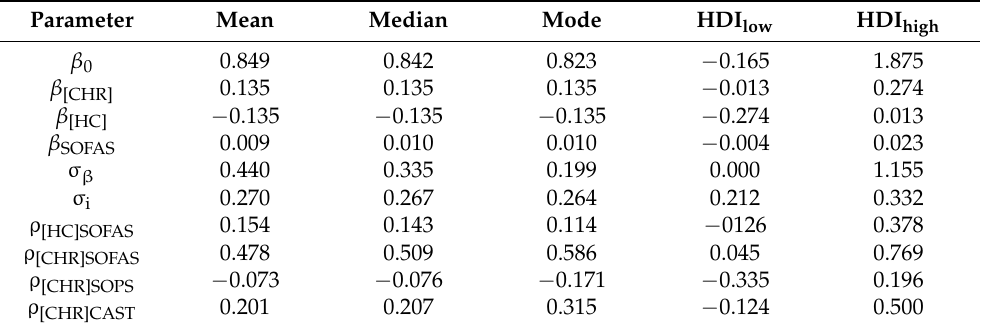
Table 2. Parameter estimates (posteriors) of the hierarchical Bayesian linear model and the Spear- man’s correlation